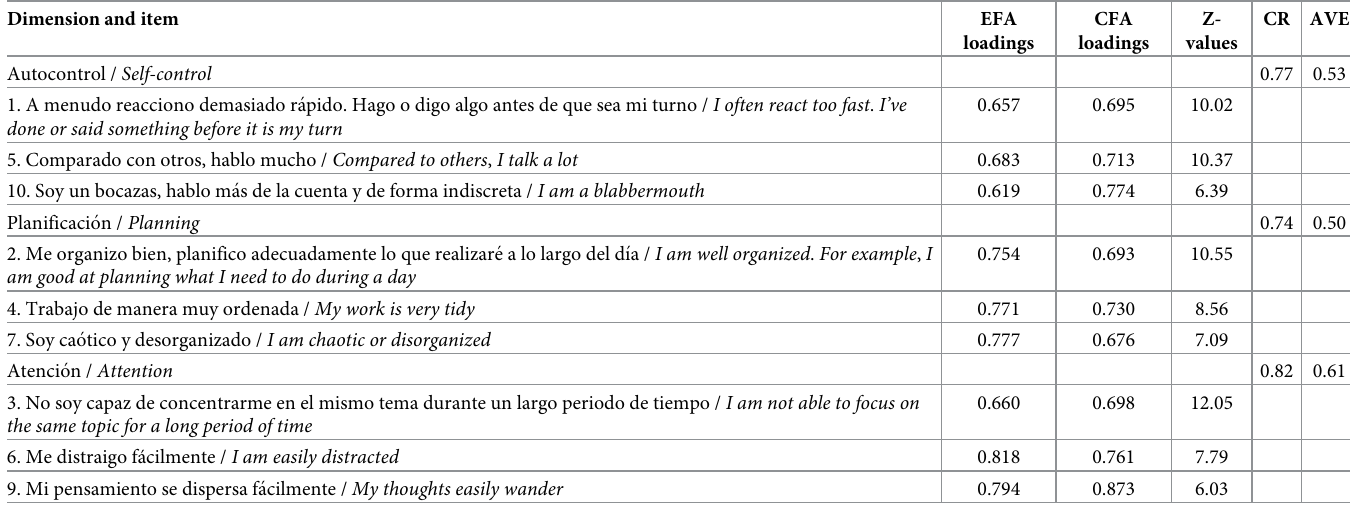
Table 2. Factor loadings, Z-values, composite reliability and average variance